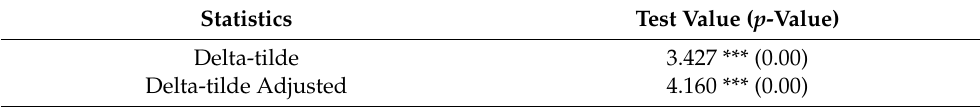
Table 4. Slope heterogeneity test.